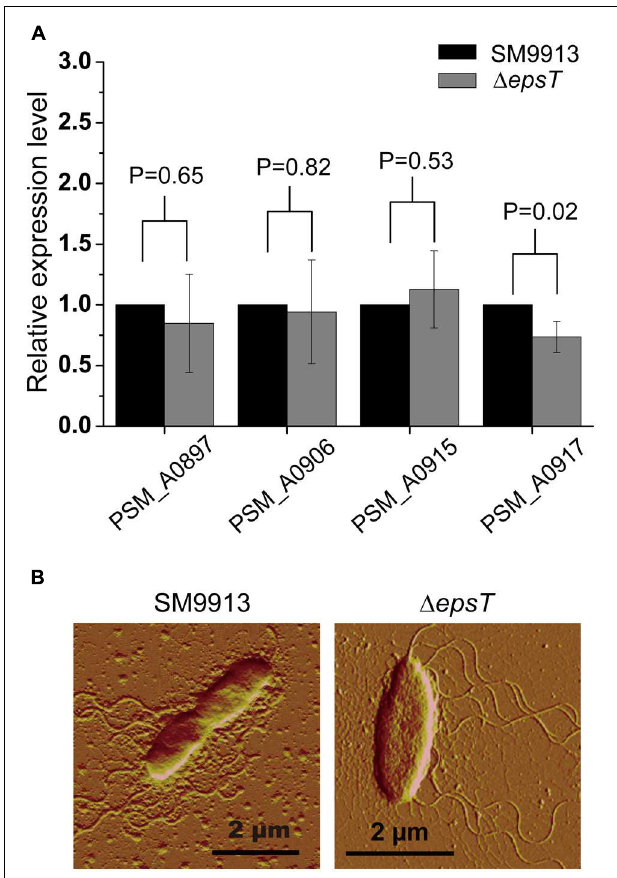
FIGURE 4 | Comparisons of lateral flagella biosynthesis between (cid:49) epsT and wild SM9913 swarming cells. (A) The relative expression levels of four lateral flagella genes in (cid:49) epsT and wild SM9913 swarming cells analyzed by real-time quantitative PCR. The data were from three independent experiments with three replicates (mean ± SD). P -value of each gene was calculated from t -test and was indicated. (B) The lateral flagella of wild SM9913 and (cid:49) epsT observed by atomic force microscopy. Cells were taken from the edge of a swarming colony and imaged by atomic force